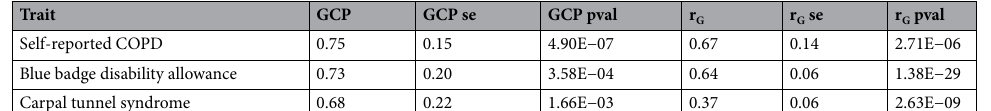
Table 1. Traits influenced by genetic liability to ADHD. This table shows significant (FDR < 5%) traits with a robust and positive genetic causal proportion (GCP > 0.60) and a positive genetic correlation with ADHD. Trait Trait causally associated with ADHD, GCP Genetic causal proportion, GCP se Genetic causal proportion standard deviation, Genetic causal proportion, GCP pval Genetic causal proportion p-value before FDR correction, r G Genetic correlation, r G se Genetic correlation standard deviation, r G p val Genetic correlation p-value before FDR correction. P-values after FDR correction are available for all traits in Supplementary File 1.